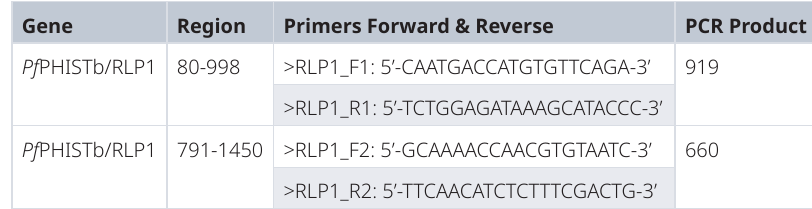
Table 2. PHISTb/RLP1 specific gene primers for Plasmodium falciparum , as designed in Primer3 plus tool. The table shows the regions on the gene where each primer should anneal as well as the expected PCR product. These are novel primers for this gene, designed and used in this study for the first